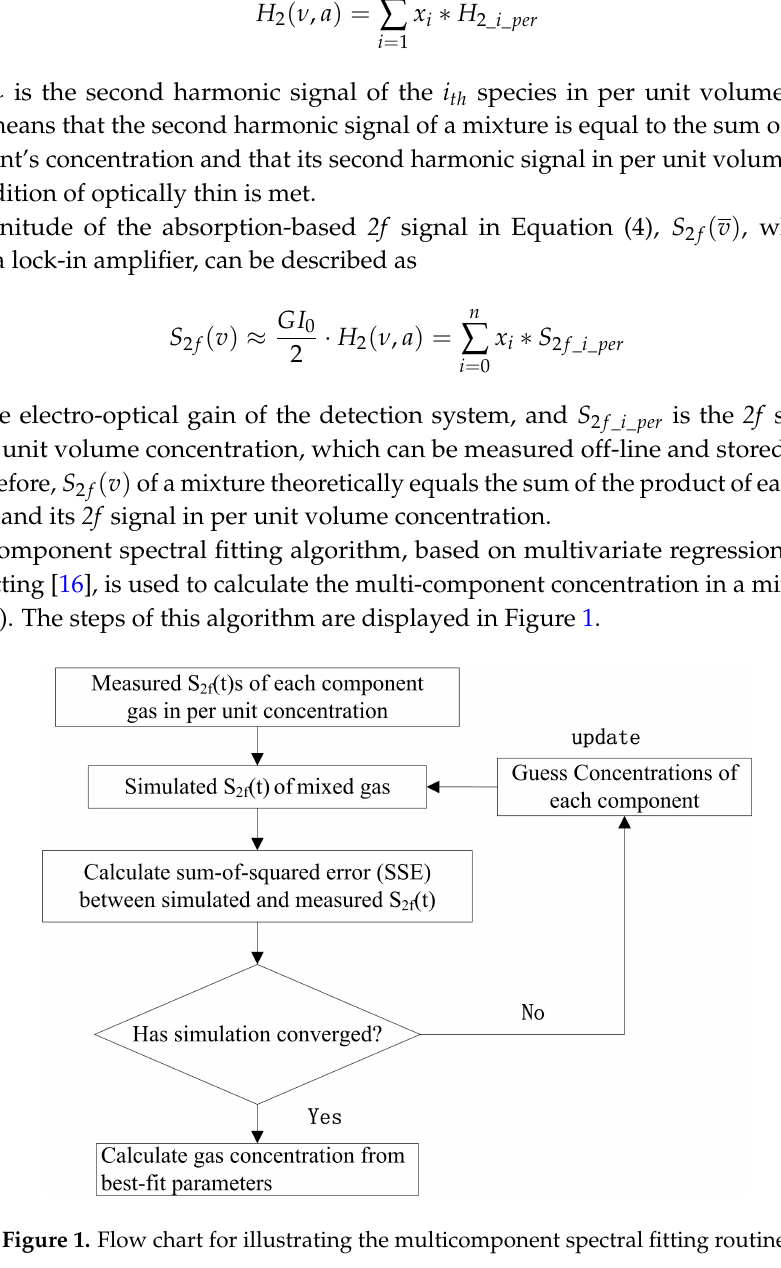
Figure 1. Flow chart for illustrating the multicomponent spectral fitting routine.